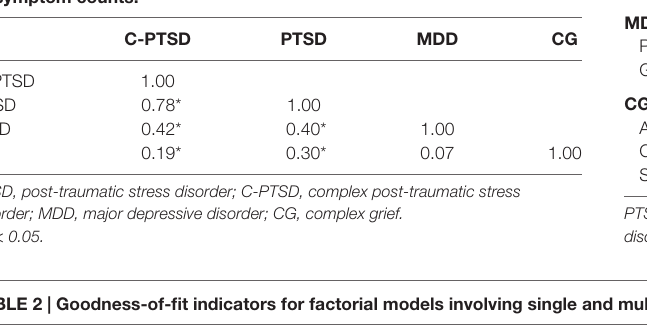
TaBle 1 | correlation matrix of c-PTsD, MDD, PTsD, and cg according to symptom counts.